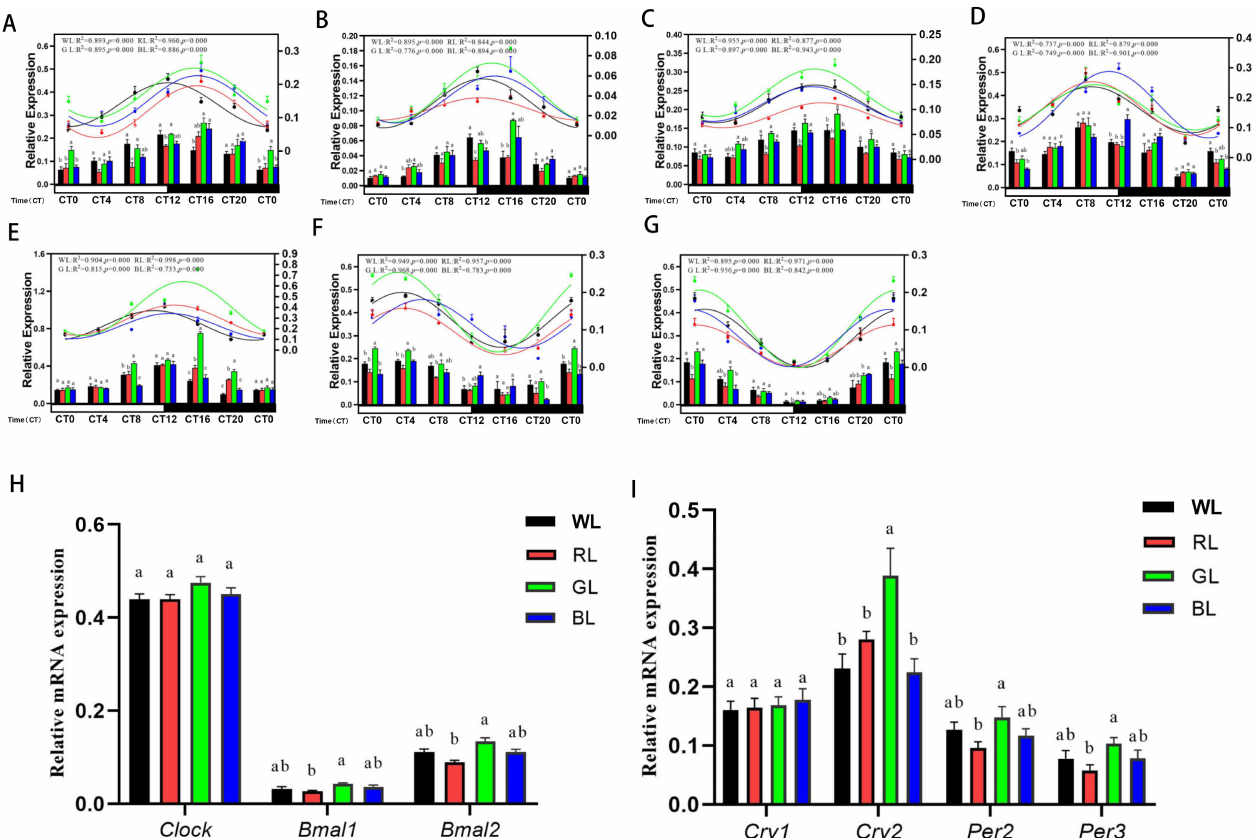
Figure 4. Circadian rhythms of pancreas clock gene transcription in the chicks under monochromatic light (12 L: 12 D). ( A ), cClock ; ( B ), cBmal1 ; ( C ), cBmal2 ; ( D ), cCry1 ; ( E ), cCry2 ; ( F ), cPer2 ; ( G ), cPer3 ; the column represents clock gene expression level (left Y-axis), and the line with symbols represents the 24-h circadian rhythm (right Y-axis). The goodness of rhythmicity (R 2 and p value) is shown on the top of each figure. ( H ): the total mRNA expression of the positive clock gene; ( I ): the total mRNA expression of the negative clock gene. The horizontal white bar on each figure represents the subjective day, and the black bar represents the subjective night. Quantitative analysis of the PCR data is shown as the mean ± SEM. CT, circadian time. Different letters indicate significant differences among the monochromatic light groups, and the light treatments are represented with different colors (black, WL; red, RL; green, GL; blue,